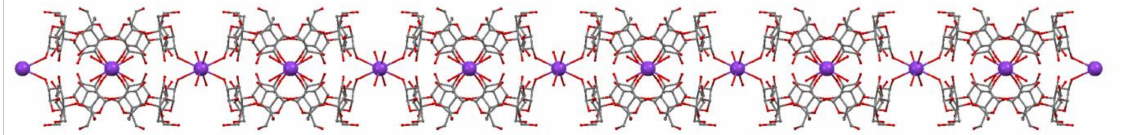
Figure 3. Sandwich-type dimer chain in ε -phase along the b-axis. Hydrogen atoms are omitted for